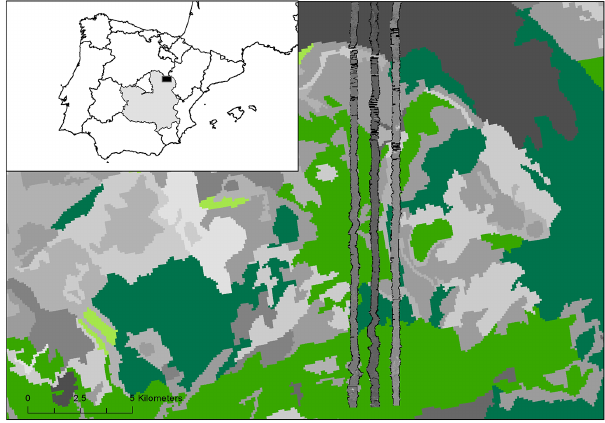
Figure 2. Study area. Shown in lighter green, mixed forest, and darker green, coniferous forest. Other land covers (including agri- cultural) in shades of grey, with darkest grey indicating an area burned by forest fire in 2005 and excluded from these analyses. The three north-south parallel strips show the lidar survey